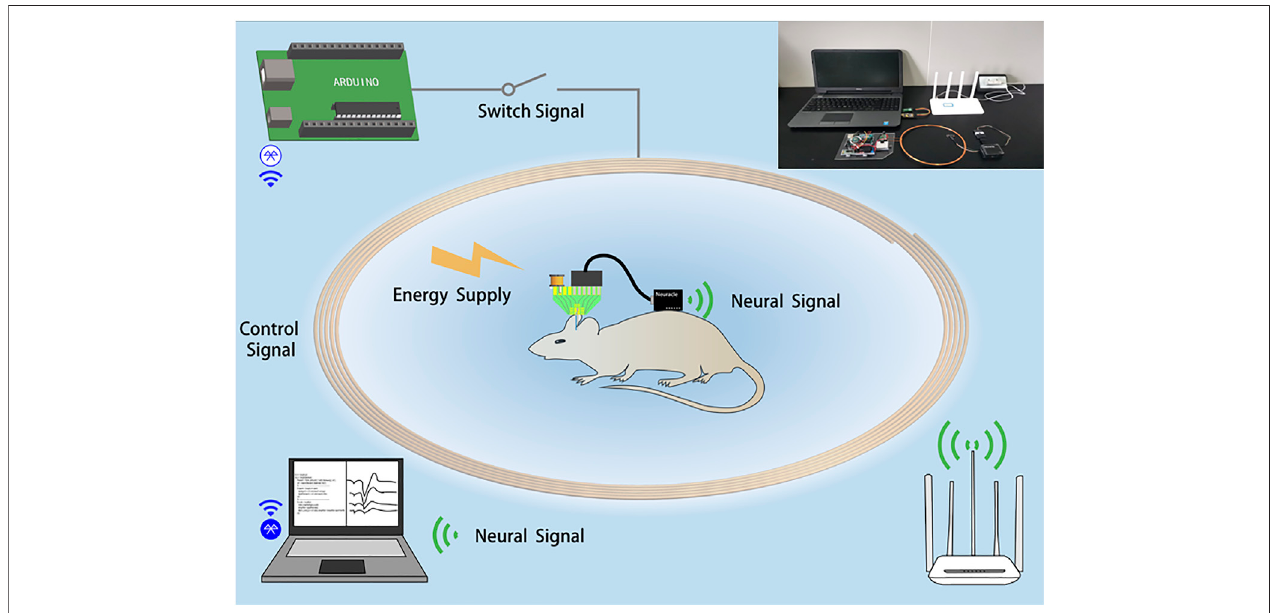
FIGURE 1 | System block diagram of the wireless closed-loop system for epilepsy detection and suppression. The illustration is a physical picture.